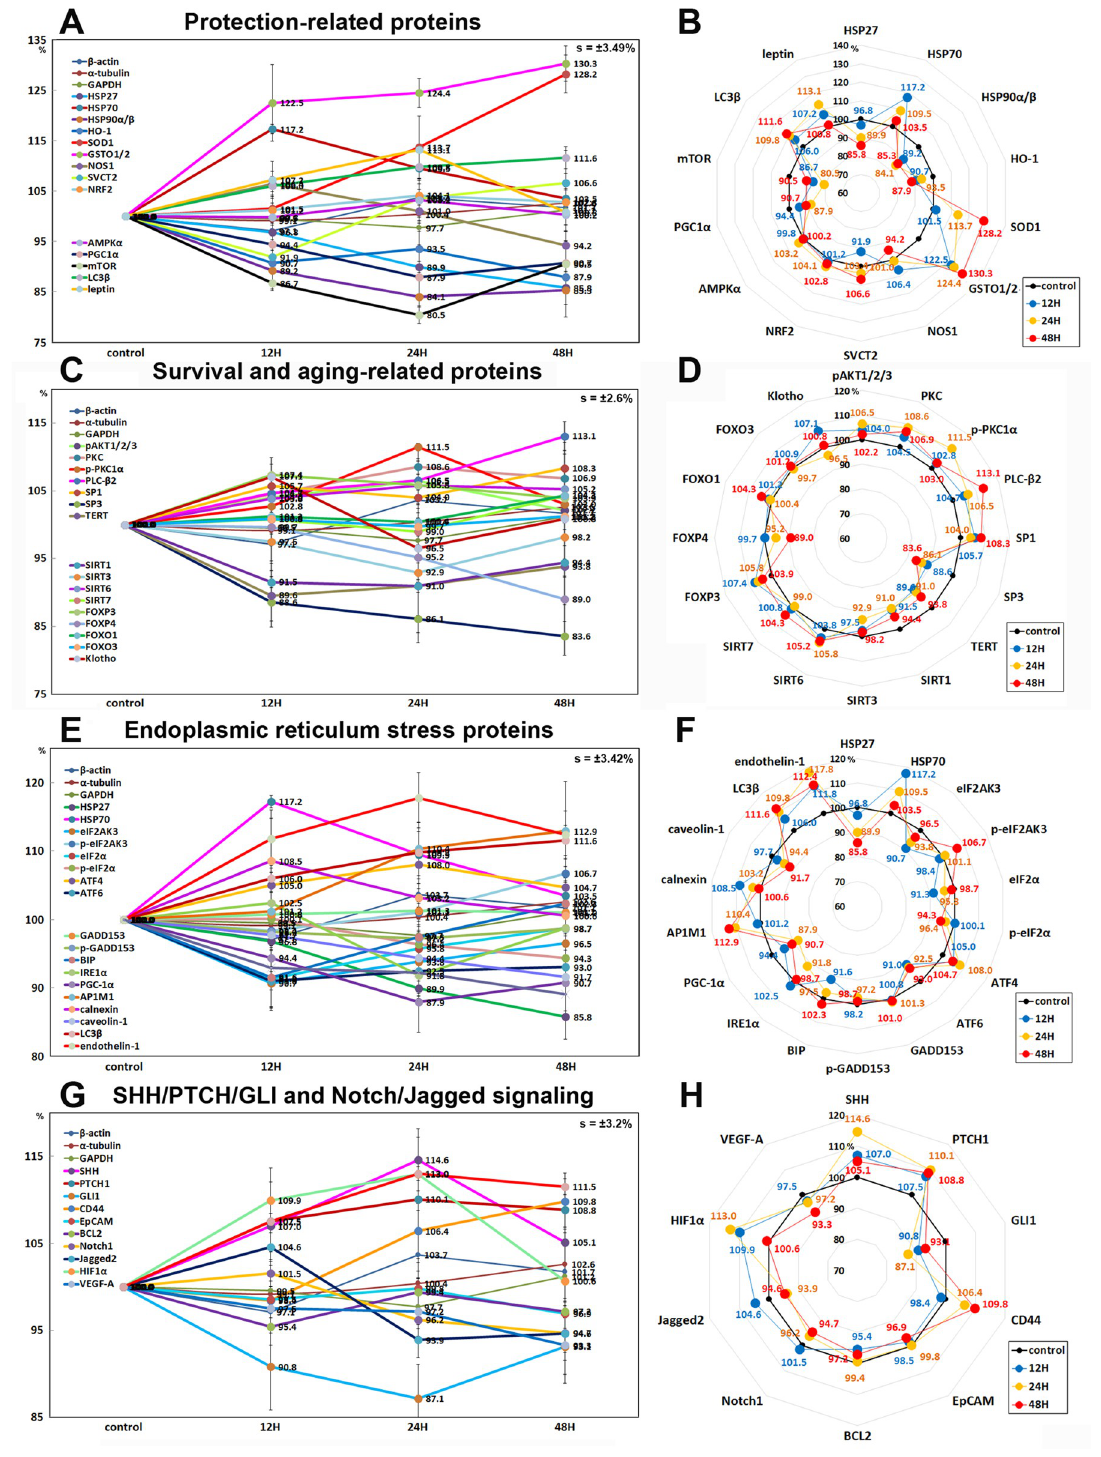
Fig 13. Expression of protection-related proteins (A and B), survival and aging-related proteins (C and D), endoplasmic reticulum stress proteins (E and F), and SHH/PTCH/GLI and Notch/Jagged signaling proteins (G and H) in 10 μ g/mL PTX-treated RAW 264.7 cells as determined by IP-HPLC. Line graphs, A, C, E, and G show protein expression on the same scale (%) versus culture time (12, 24, or 48 h), whereas the star plots (B, D, F, and H) show the differential expression levels of the proteins at 12, 24, or 48 h after PTX treatment on the appropriate scales (%). The thick black line, untreated controls (100%); the blue, yellow, and red dots show differential protein levels after PTX administration for 12, 24, or 48 h, respectively. https://doi.org/10.1371/journal.pone.0261797.g013 PLOS ONE | https://doi.org/10.1371/journal.pone.0261797 March 25,